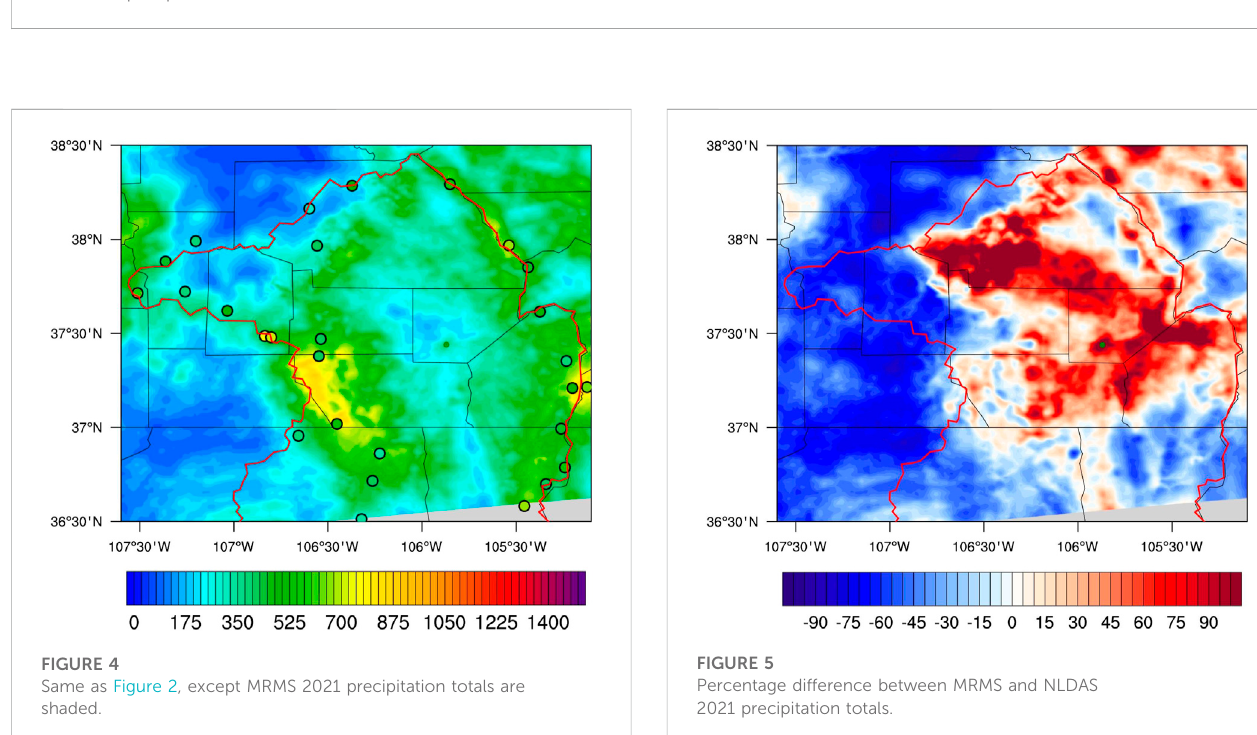
FIGURE 3 2021 total precipitation at SNOTEL station locations for all four data sets.